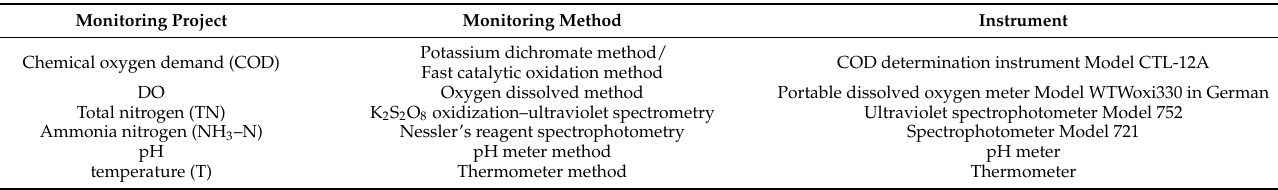
Table 3. Water quality monitoring projects and